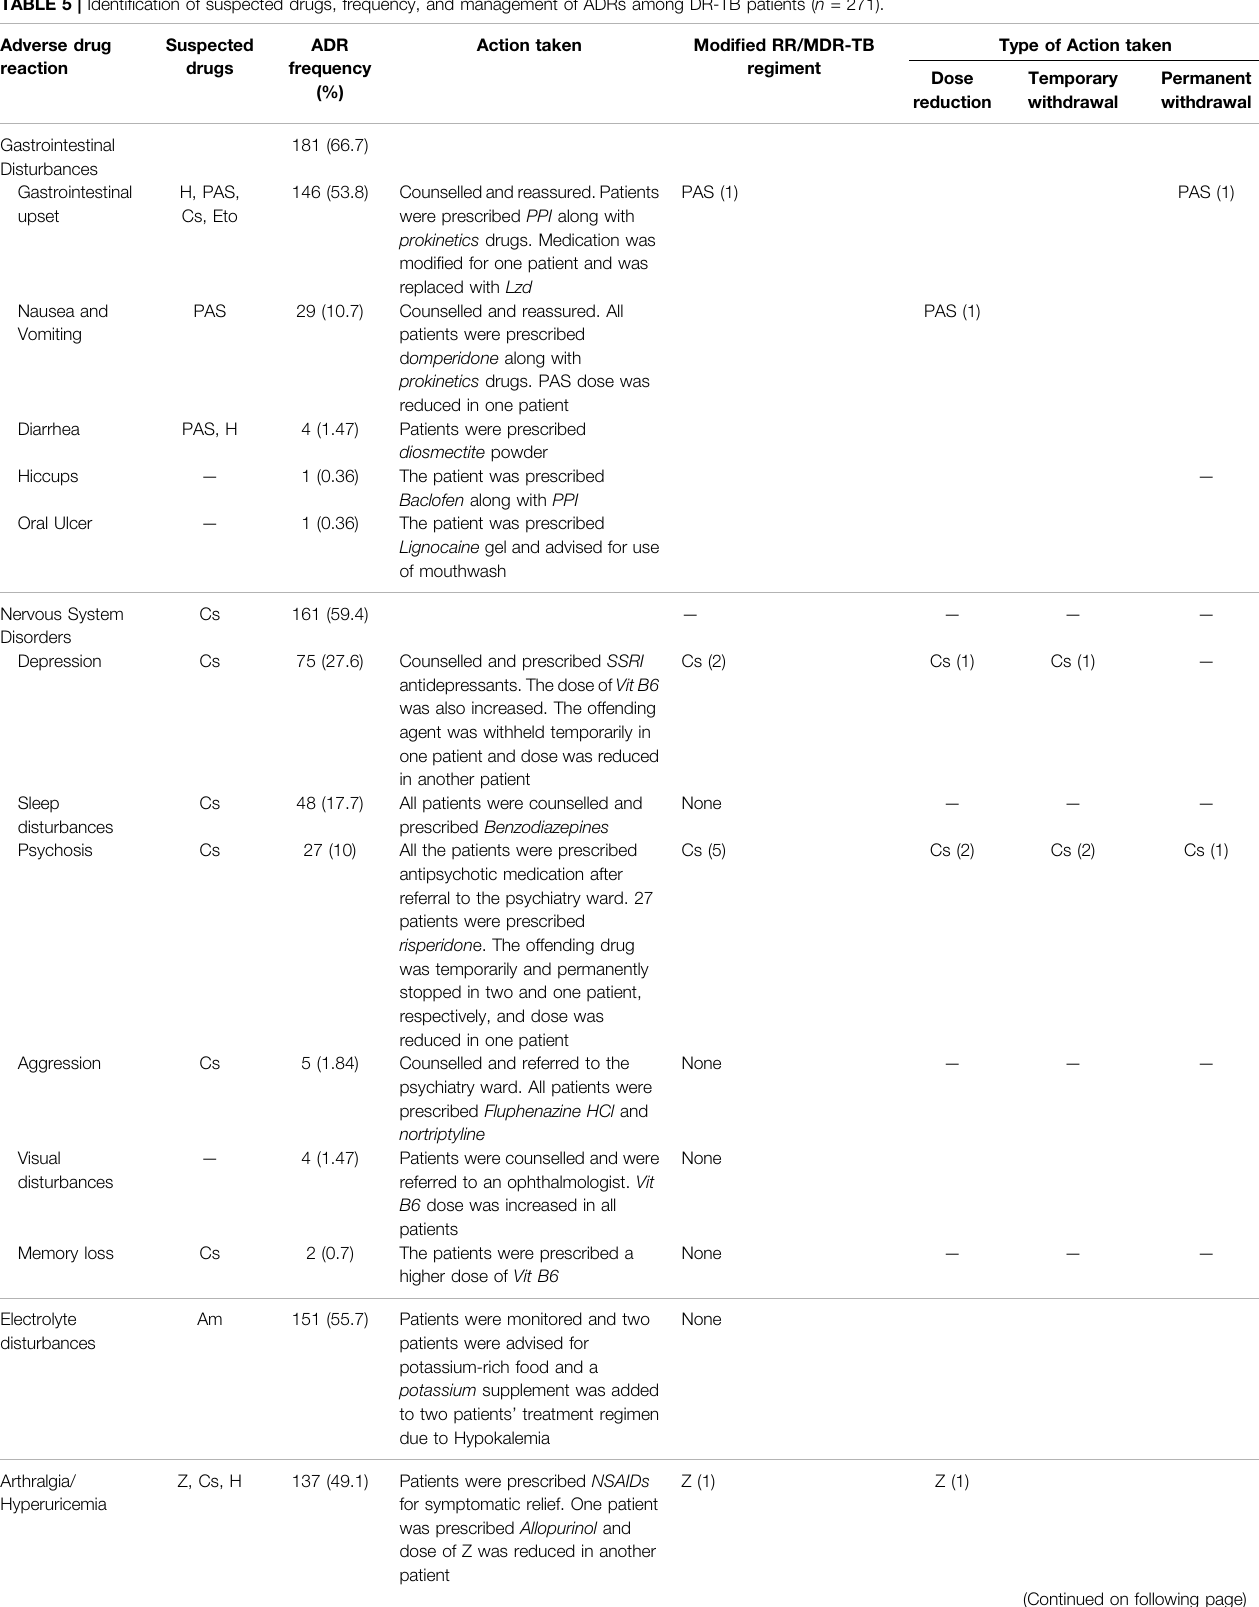
TABLE 5 | Identi fi cation of suspected drugs, frequency, and management of ADRs among DR-TB patients ( n = 271). Adverse drug